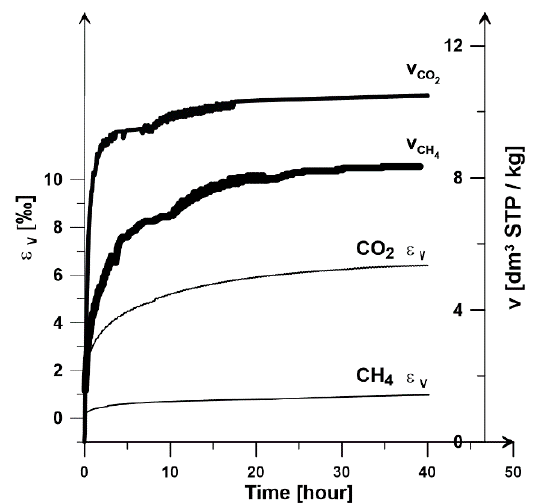
Figure 2. Sorption-dilatometric kinetics of the tested sample with respect to CO 2 and CH 4.